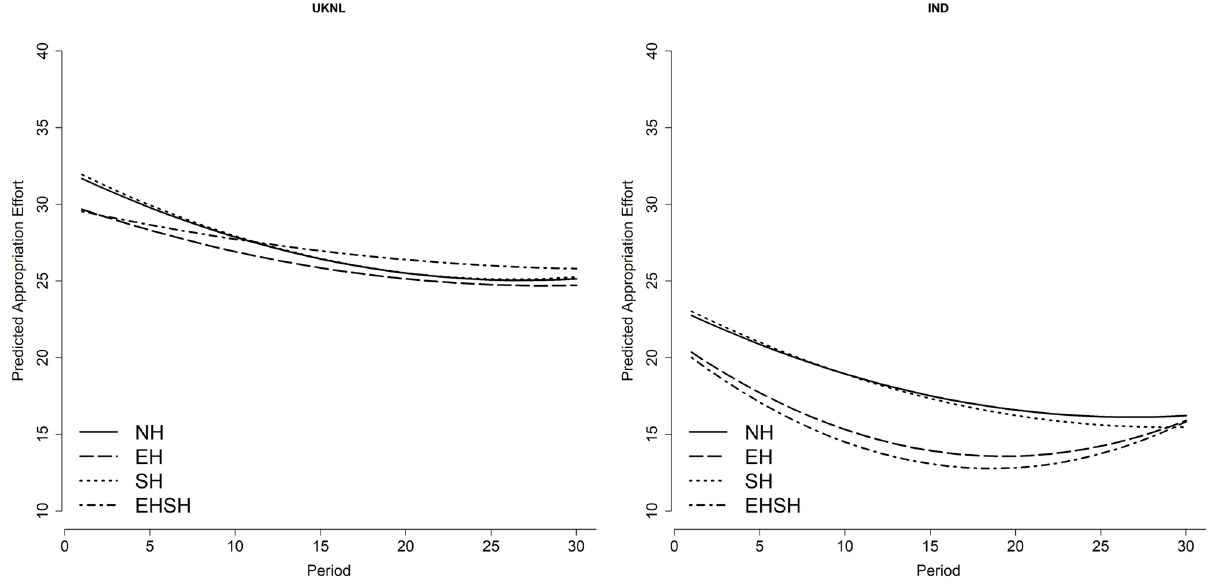
Fig 4. Predicted appropriation effort per treatment per